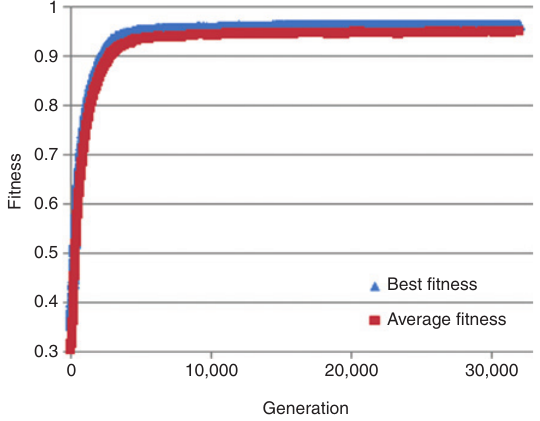
Figure 6: Fitness of Generations for Experiment